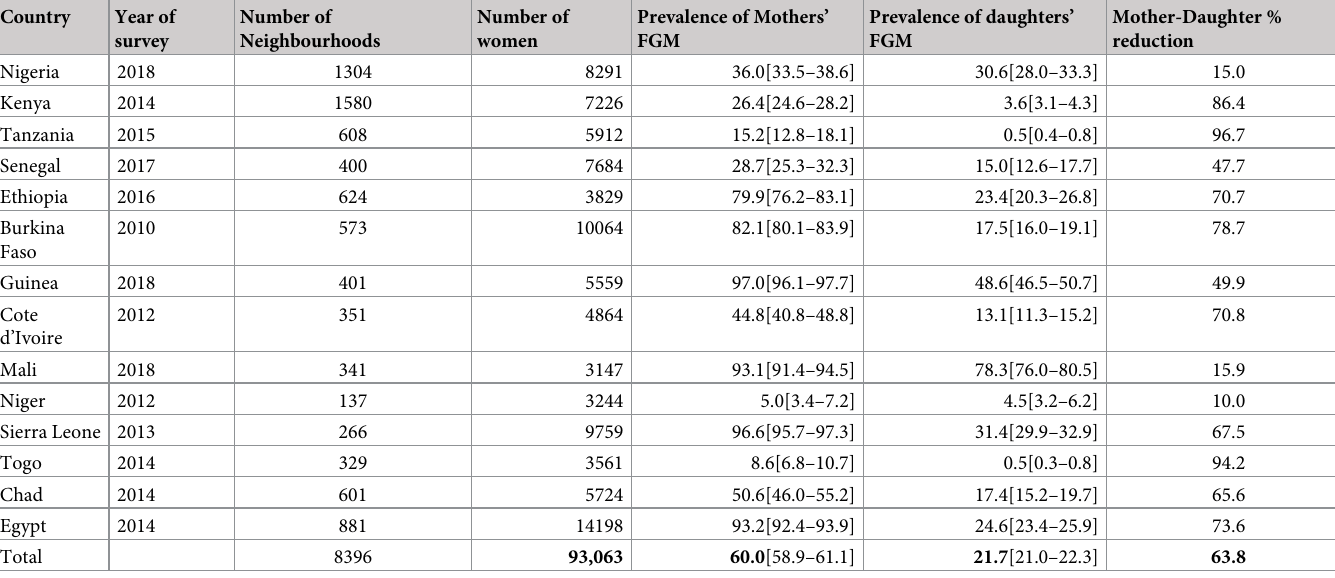
Table 1. Data characteristics and prevalence of FGM among respondents and their daughters. DHS